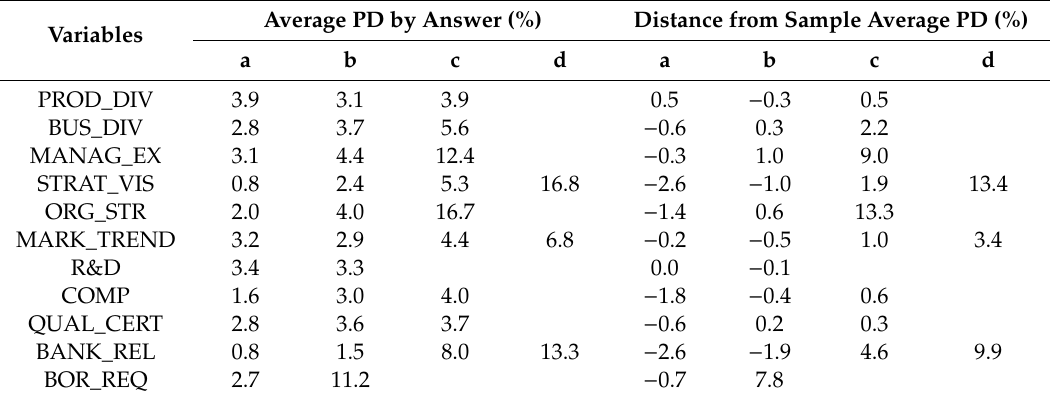
Table 3. Strategic Variables.